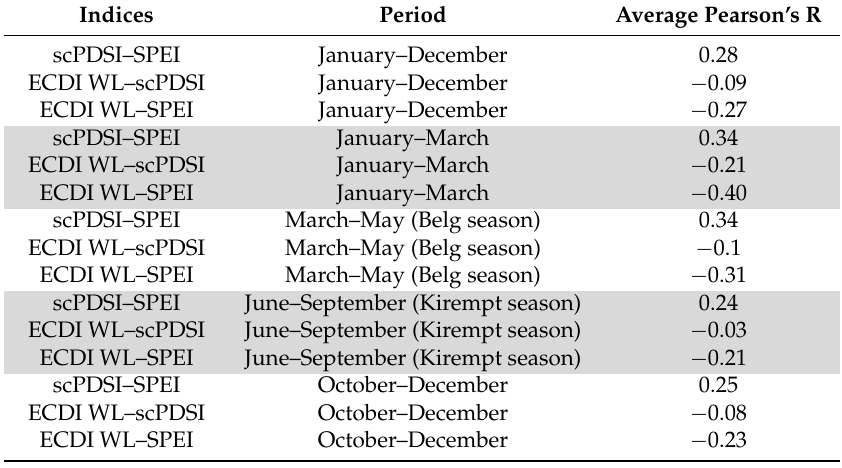
Table 1. Correlation for all Index Combinations and for all Grid Points in Ethiopia. Table 2. Correlation for all Index Combinations and for all Grid Points in Ethiopia.